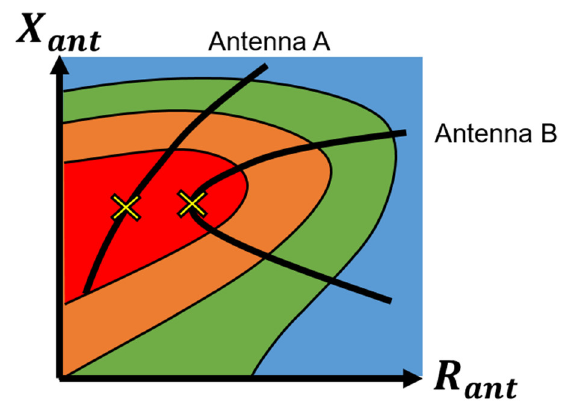
Figure 8. Image of the optimum design flow in steps 2 and 3.